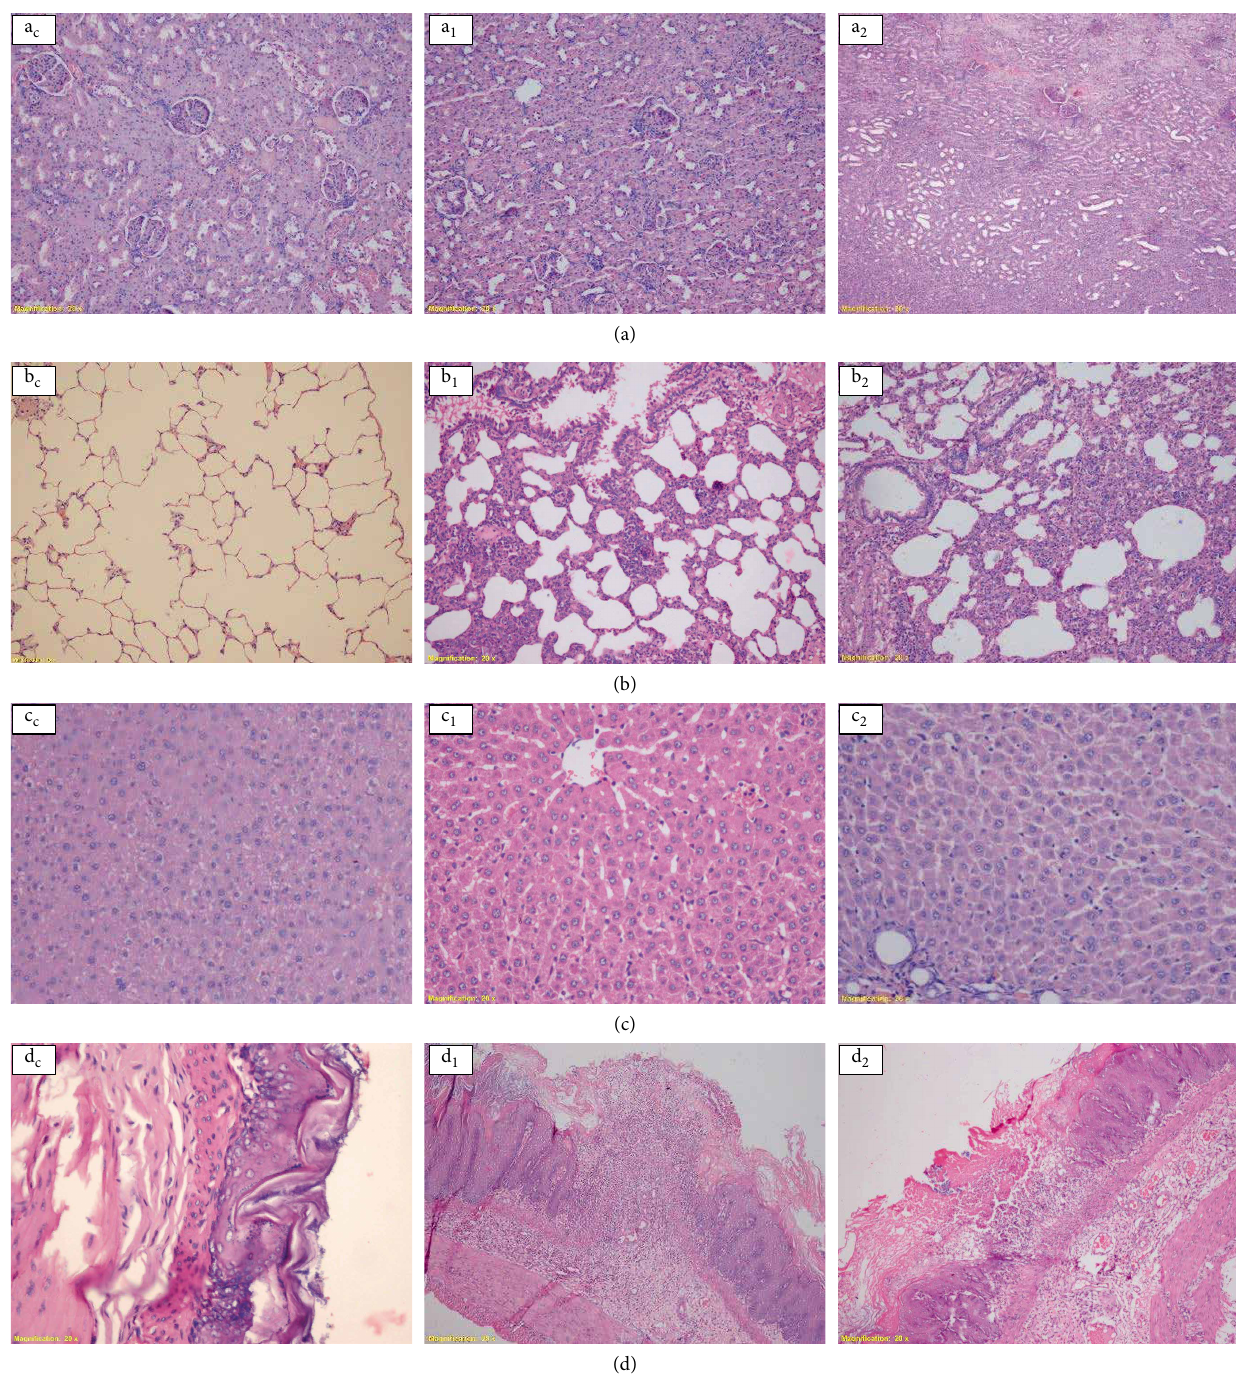
Figure 3: Photomicrographs of the sections from kidney (a), lung (b), liver (c), and esophagus (d) of rats treated with Minthostachys mollis essential oil during 28 days. Subindices C, 1 and 2 refer to the control groups, 250 and 500 mg/kg/day, respectively. H-E staining,